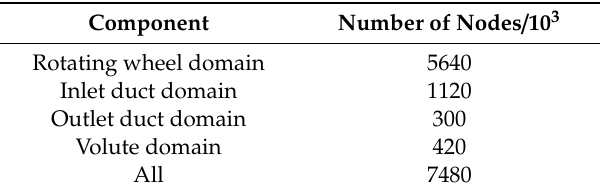
Table 2. Number of nodes of the computational domain.